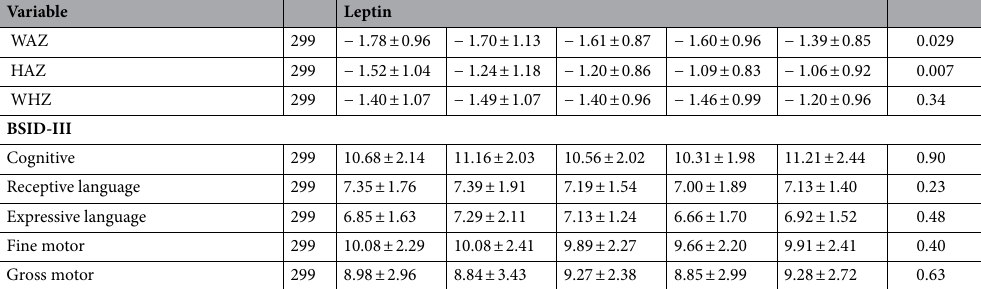
Table 1. General characteristics of the infant cohort. SES socioeconomic status, LBW low birth weight, SGA small for gestational age, WAZ weight-for-age z-score, HAZ height-for-age z-score, WHZ weight-for-height z-score, BSID-III the Bayley Scales of Infant and Toddler Development test, third edition. a Percent of infants reported to be exclusively breastfed throughout the first year of life. b Percent of infants classified as LBW or SGA at